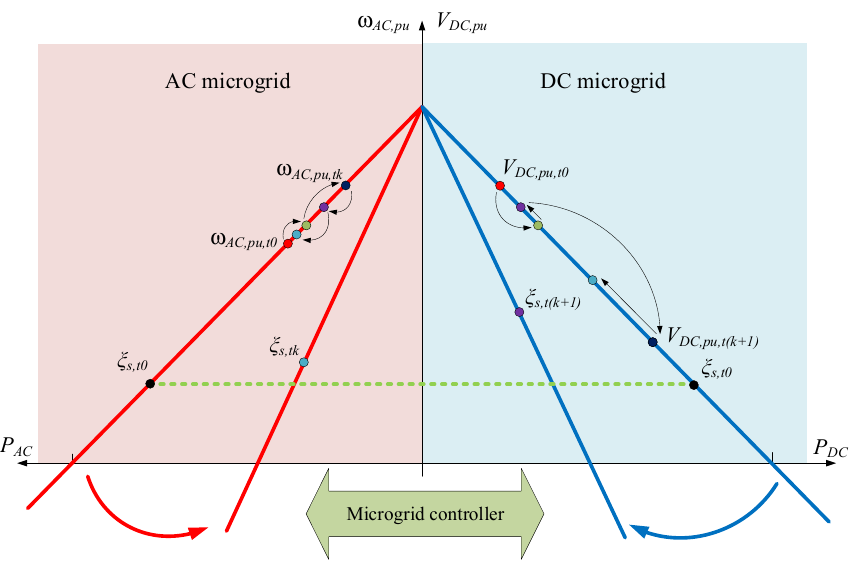
Figure 10. The principle of setting droop in a hybrid microgrid.